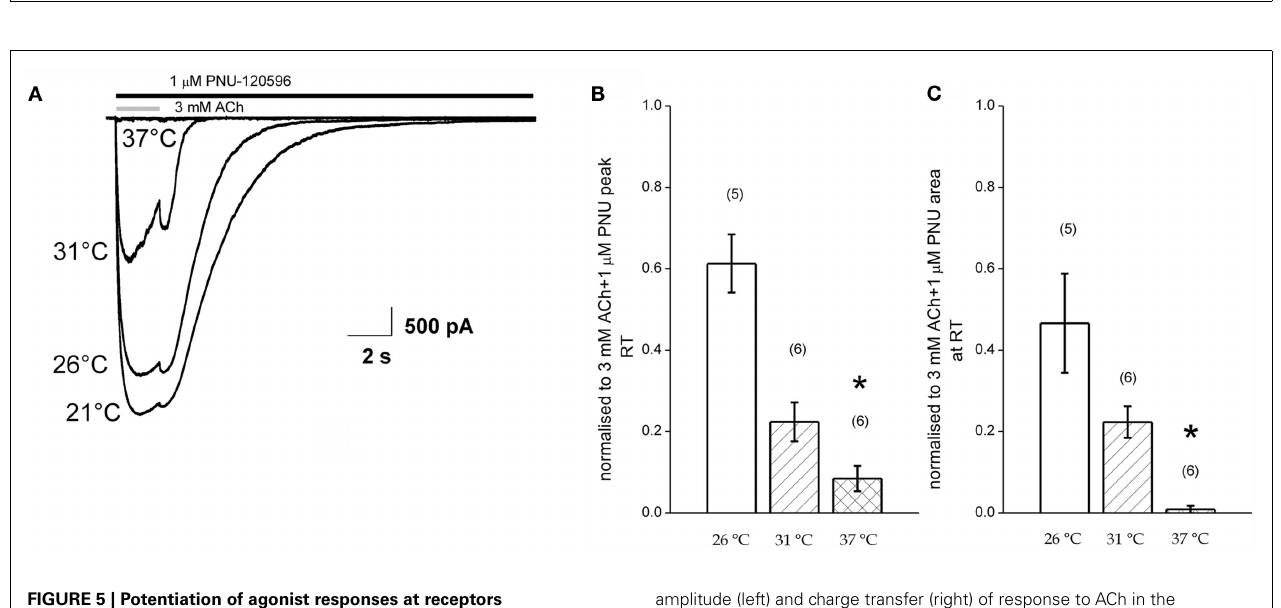
FIGURE 4 | PNU120596-mediated dedesensitization is strongly attenuated at physiological temperatures. (A) ACh-mediated current responses at room temperature and 37˚C in the same example cell. (B) A graph plotting the changes in amplitude and charge transfer produced by increasing the recording temperature to 37˚C. (C) Example traces showing